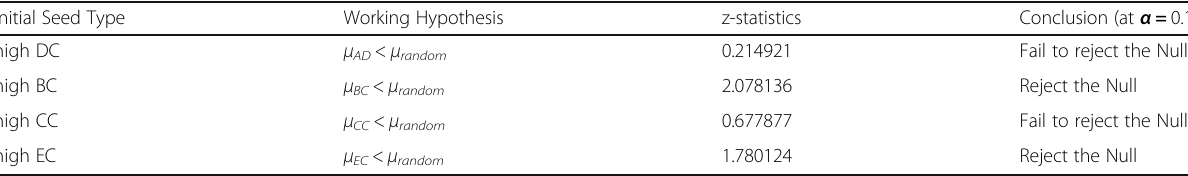
Table 2 Results of the hypothesis tests (on the different networks) Initial Seed Type